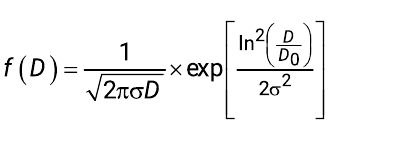
Then, the mean diameter < D > and standard deviation σ D were calculated (Equation 2 and Equation